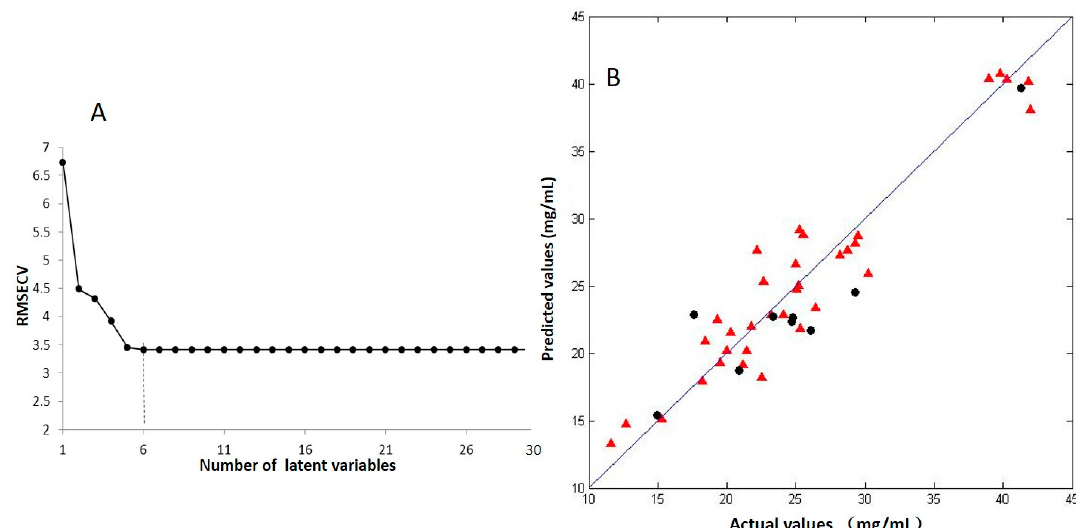
Figure 3. The partial least squares regression model between the radical scavenging activity and the volatile components: ( A ) Selection of the optimal latent variables by 10-fold cross validation. The first six latent variables were selected; ( B ) actual measured DPPH values versus their predicted values obtained by partial least squares regression model. The size of data set is 43 × 80. ( ▲ ) calibration set; ( ● ) validation set.